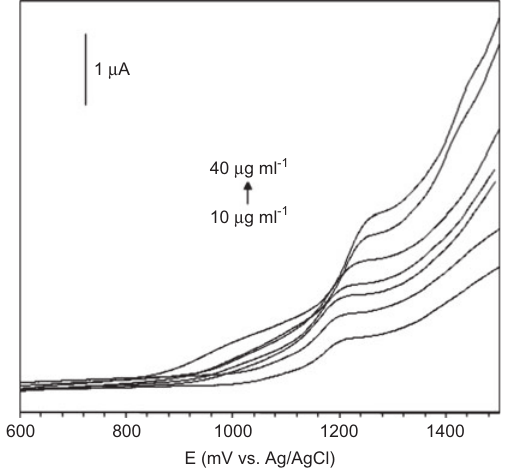
Figure 6 Current-potential curves for different concentrations of carvedilol in acetonitrile solution containing 0.1 m TBAClO 15, 20, 25, 30, 35 and 40 µ